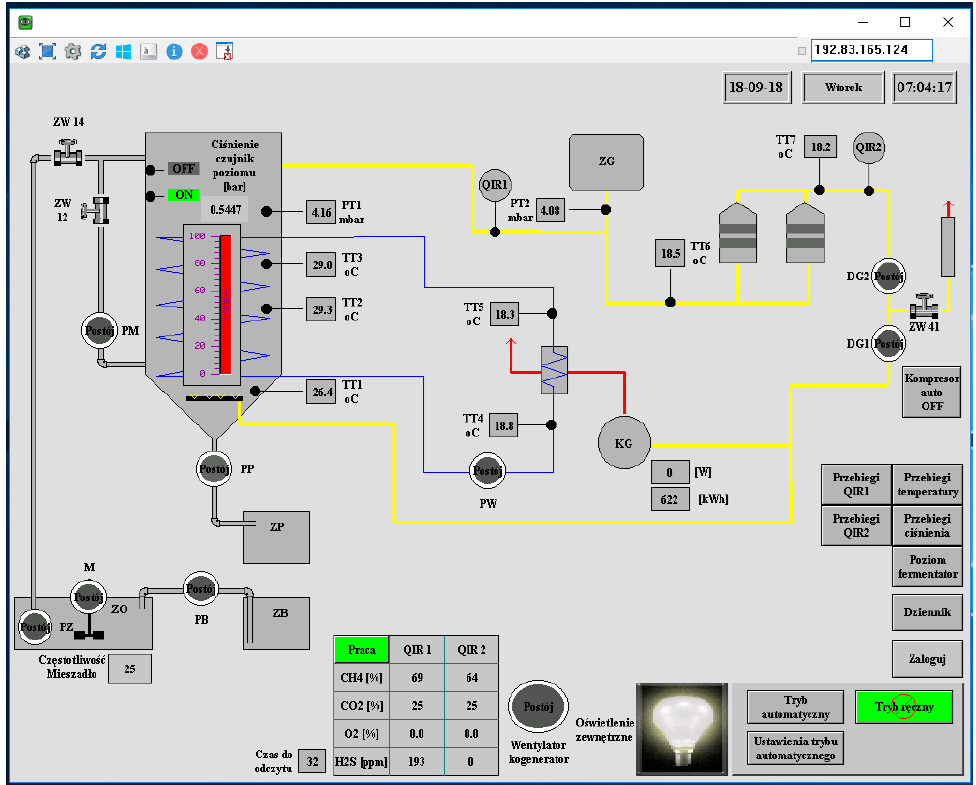
Figure 4. Synoptic table for control system, raw biogas production and desulphurized biogas treatment; detailed description in Walowski’s work [76].